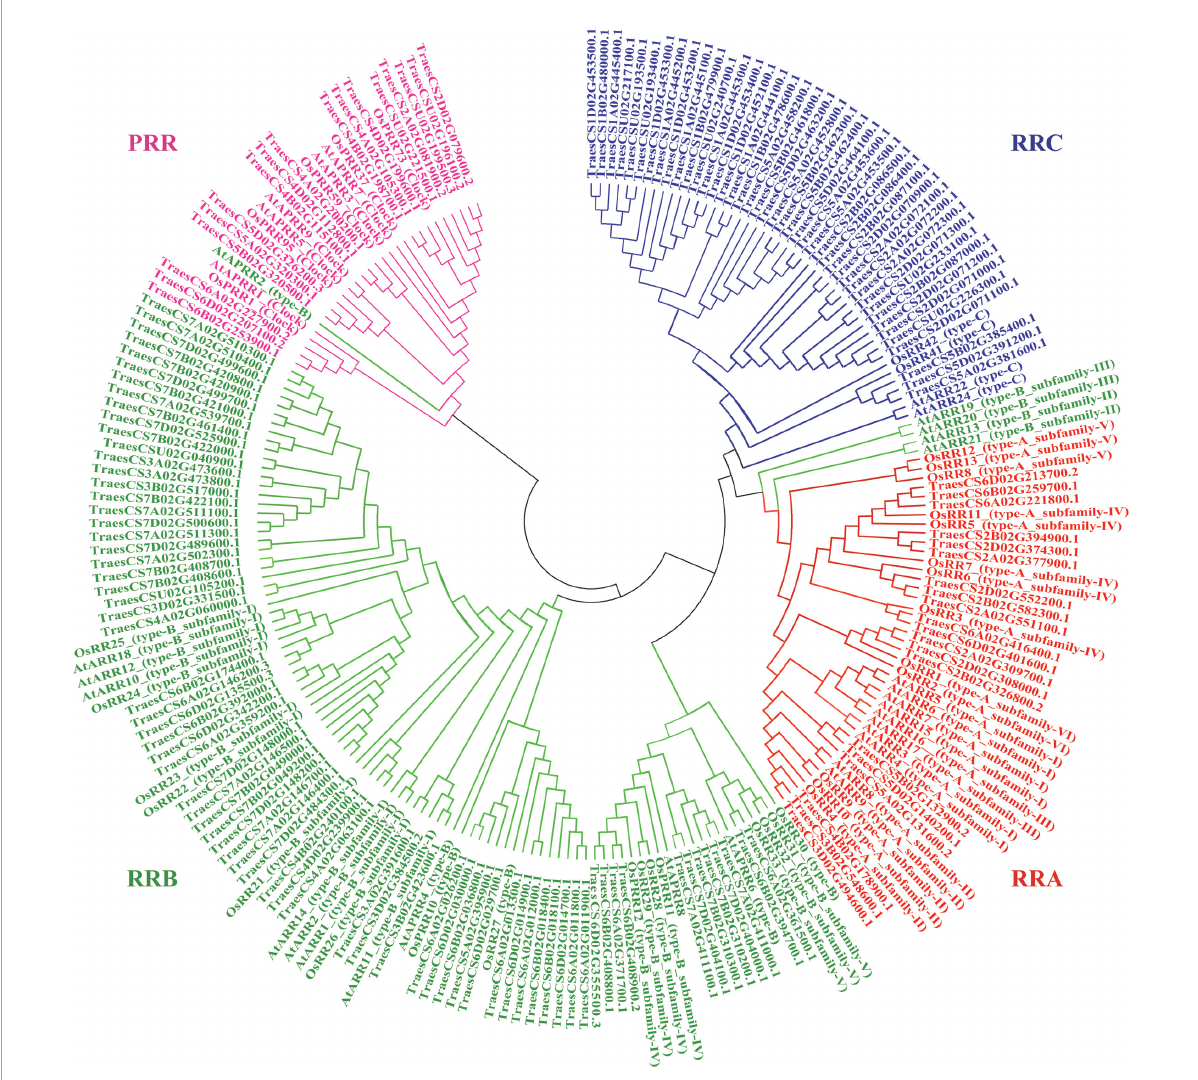
FIGURE1 Phylogenetic analysis of RR proteins among the wheat, Arabidopsis , and rice. All RR proteins were allocated into four clades. Red, green, blue, and pink represent RRA, RRB, RRC, and PRR, respectively. The unrooted tree was established by the neighbor-joining method using the MEGA7.0 software with 1,000 bootstrap